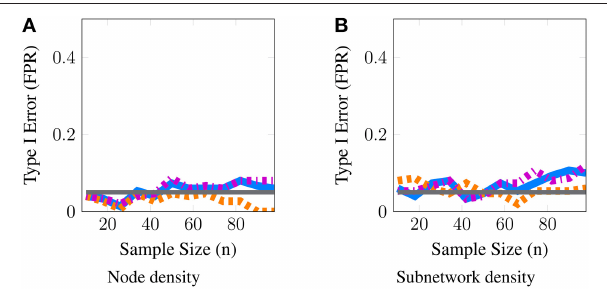
FIGURE 4 | Statistical type I error is controlled for both node and subnetwork density. These simulations evaluate the level of our tests; we report the estimated type-I error as a function of subject sample size n . The gray line represents the 5 % level of the test. Here, we provide a representative simulation for node and subnetwork density in the moderate SNR regime with ( p = 50 , t = 100) and ν 2 = 0.25 for node density and ν 2 = 1 for subnetwork density. All methods approximately control type I error across all scenarios studied for both metrics. The full panel of simulations that complement the power analyses in Figures 2 , 3 are included in supplementary